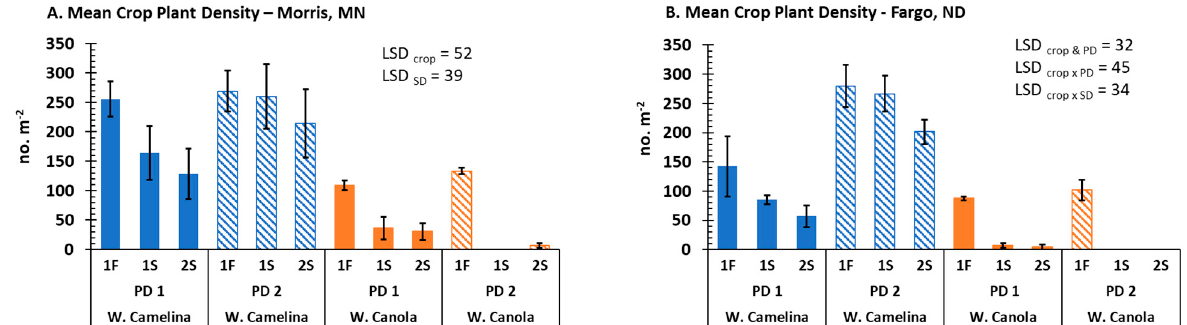
Figure 1. Plant densities of winter camelina (cv. Joelle) and 10 bulked accessions of the most freezing tolerant winter canola/rapeseed (W. Canola) at Morris, MN ( A ) and Fargo, ND ( B ). Plant densities were recorded prior to winter (1F) and in spring of 2020 (1S, 2S). Error bars represent the standard error of mean.